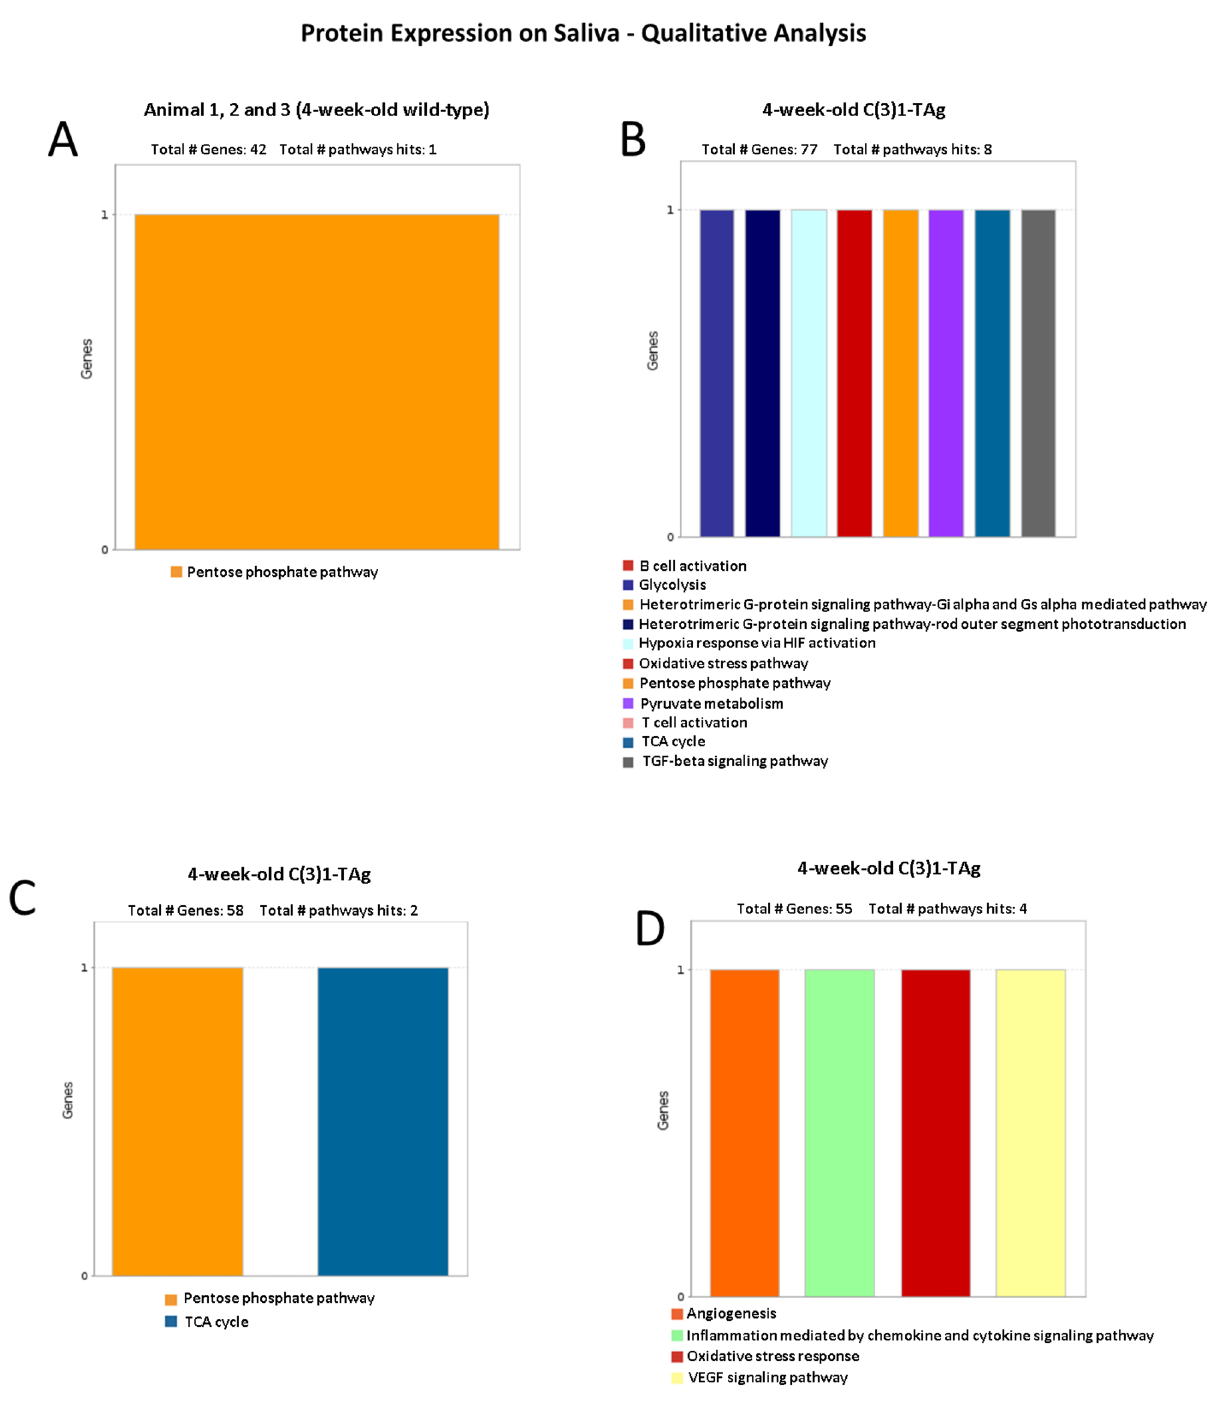
Figure 2. Qualitative analysis of the main proteins pathways expressed in the saliva samples of 4-week-old wild-type mice ( A ) versus ( B – D ) C3(1)-TAg mice. All three wild-type animals had the same protein pathway expression and are represented by Fig. 1A. Four-week-old C(3)1-TAg animals 1, 2 and 3 presented complex pathways and are represented separately (Fig.